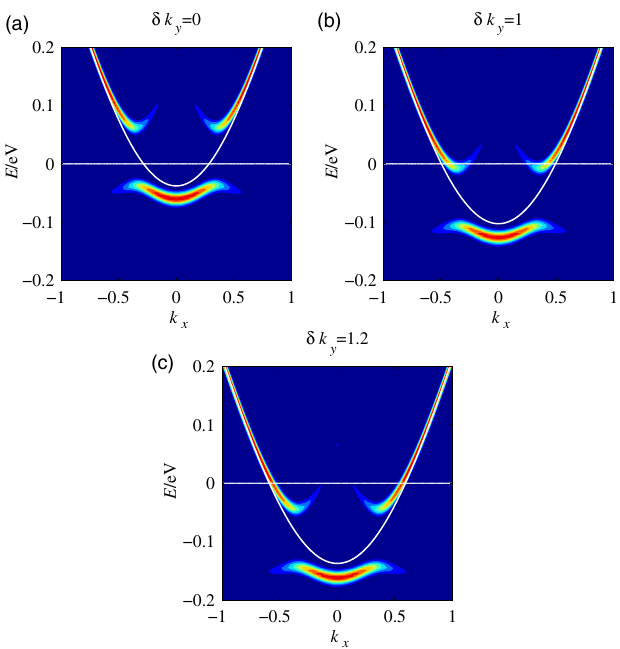
FIG. 8. Plot of the energy spectrum vs k x for (a) k y ¼ π , δ k 0 , (b) δ k 1 . 0 , and (c) δ k 1 . 2 . The CDW wave vector y ¼ y ¼ y ¼ is assumed to be 1 . 2 Q , and the gap is set to be 0.05 eV. Panel (c) corresponds to a cut through the Fermi arc, while panel (b) is a cut near the end of the arc. Note that the state at the Fermi level arises by a state moving from above, leaving a gap below the Fermi level, in strong disagreement with the data shown in Figs. 3(b) –